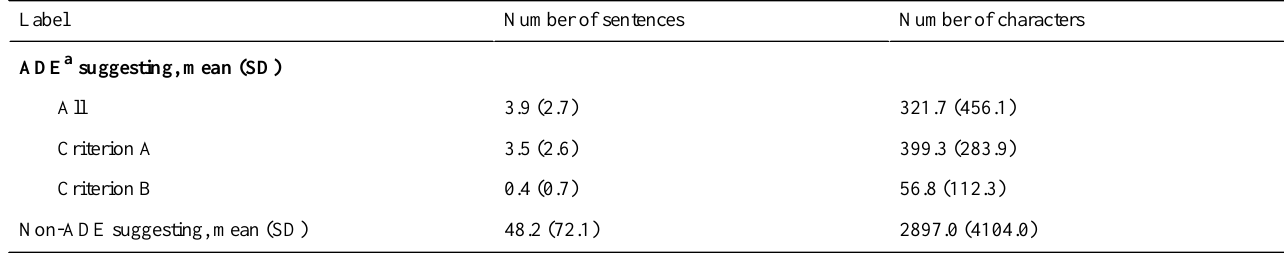
Number of charactersNumber of sentencesLabel